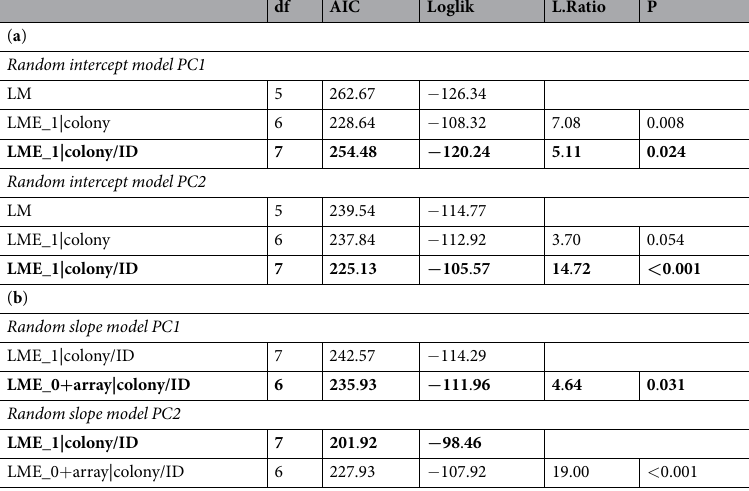
Table 2. Log-likelihood Ratio tests to estimate inter- and intra-individual variability on the two principal components (PCs) of the principal component analysis (PCA). ( a ) To study inter-individual variability we compared a linear model (LM) built using each PC as a response variable and age, body size and experimental array as fixed variables with two mixed effect models (LMEs) using colony or individual nested in colony as random effects. ( b ) To study intra-individual variability we compared the random intercept model (LME_1|colony/ID) previously built using each PC with a random intercept and slope model (LME_0 + array|colony/ID). Degree of freedom (df), Akaike Information Criterion (AIC), Log-likelihood values (Loglik) and Log-likelihood ratio test (L.Ratio) are presented with the corresponding p-values. Significant effects are highlighted in bold.